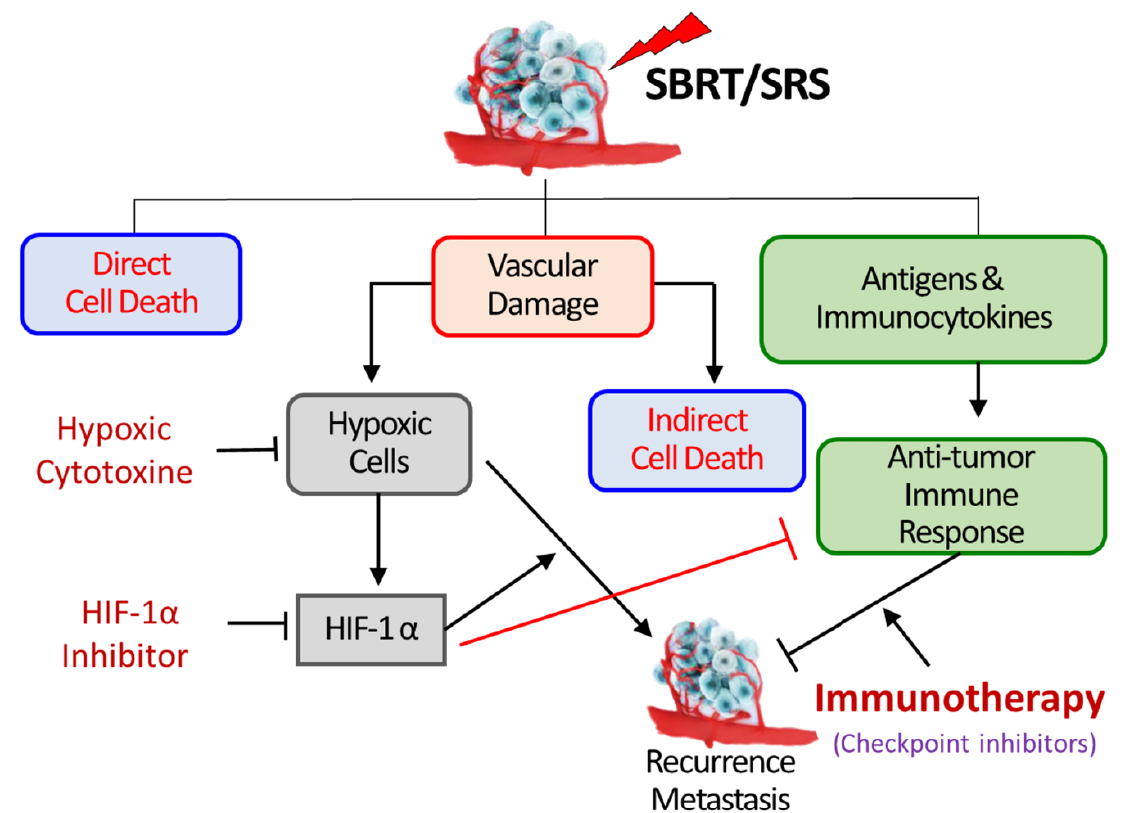
Figure 1. SBRT/SRS (SABR) kills tumor cells by three mechanisms; first—direct DNA damage, second—indirect cell killing via vascular damage, third—promoting immunologic cell killing. The vascular damage increases the expression of HIF-1α in tumor cells and stroma cells, which promotes the proliferation of hypoxic tumor cells leading to recurrence and metastasis. HIF-1α also activates various immune-suppressive pathways, thereby masking the radiation-induced increase in anti- tumor immune response. Inhibition of HIF-1α may suppress the survival and proliferation of hypoxic cells and also stimulate the anti-tumor immune response [3].